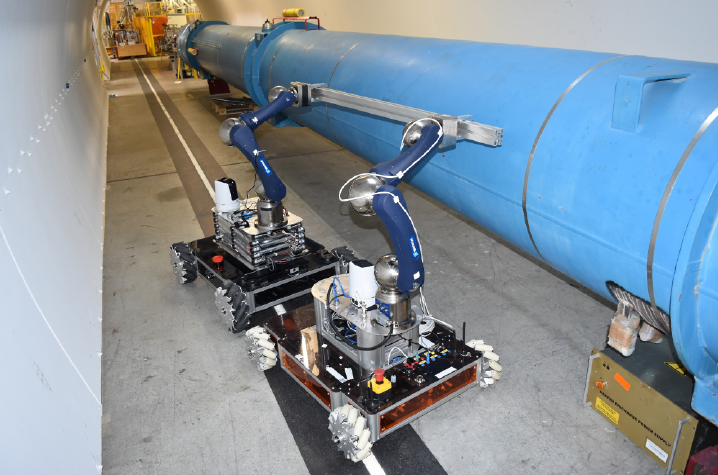
Figure 1. Cooperative intervention at a European Center for Nuclear Research (CERN) experimental